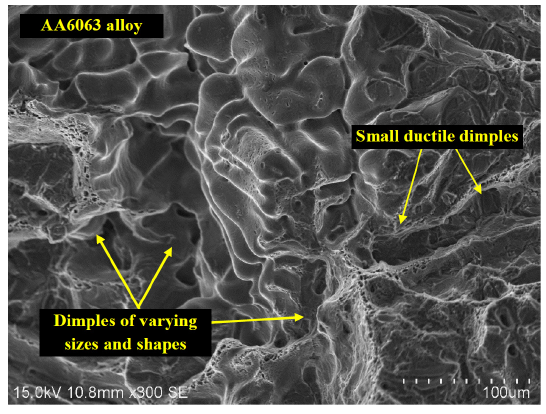
Figure 11. VP-SEM fractography of pure casted AA6063 alloy without added fly